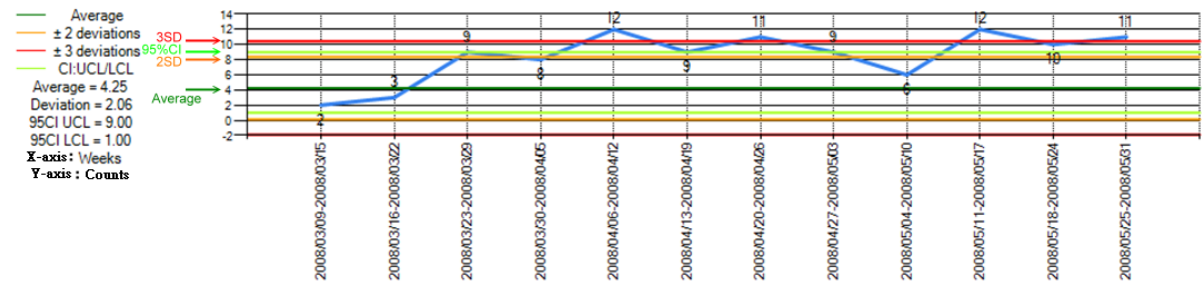
Figure 6. Control chart for visualization of the time series of the MDRO classification results in a defined patient population (eg, the whole hospital). This chart displays the numbers of vancomycin-resistant Enterococcus faecium isolates (germ criteria, y-axis) by week from March 9, 2008, to May 31, 2008